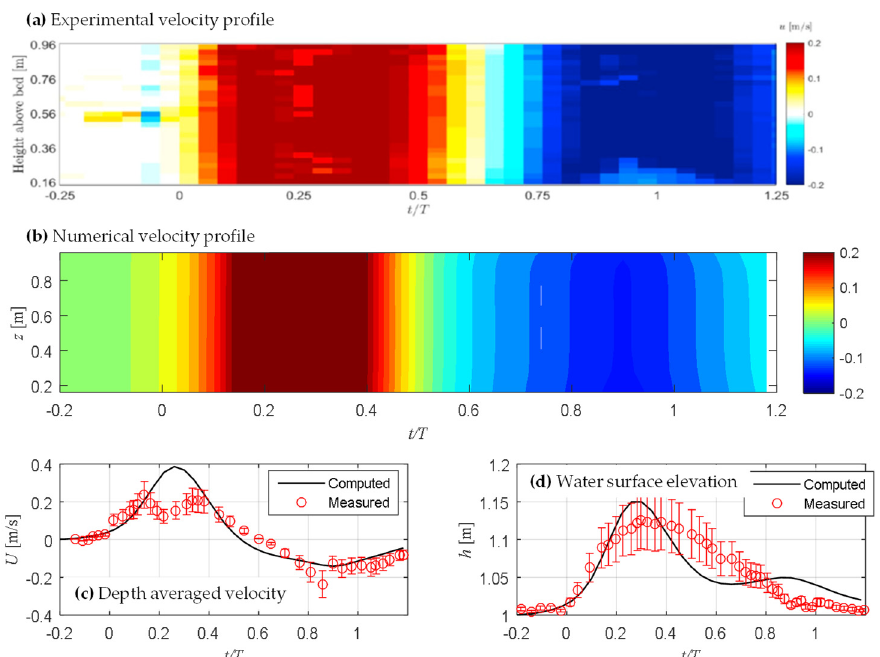
Figure 3. Comparison of flow characteristics at the slope toe between CFD computed and experimentally measured results: ( a , b ) temporal variation of velocity profile; ( c ) time history of depth-averaged velocity; ( d ) time history of water surface elevation.